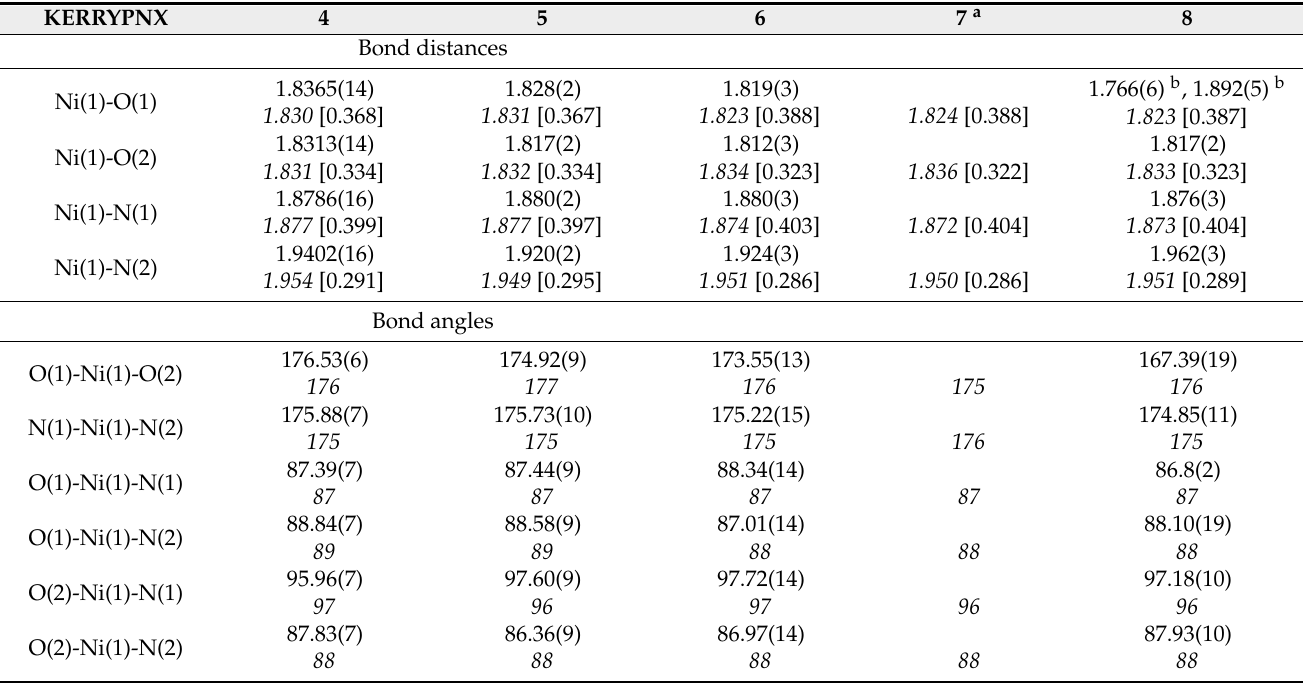
a No X-ray structure data. b rotational disorder of the [C 6 H 4 O] fragment over two positions with equal occupancy (see Section 3.3 Figure 4. The DFT-optimized structure of complex 7 .